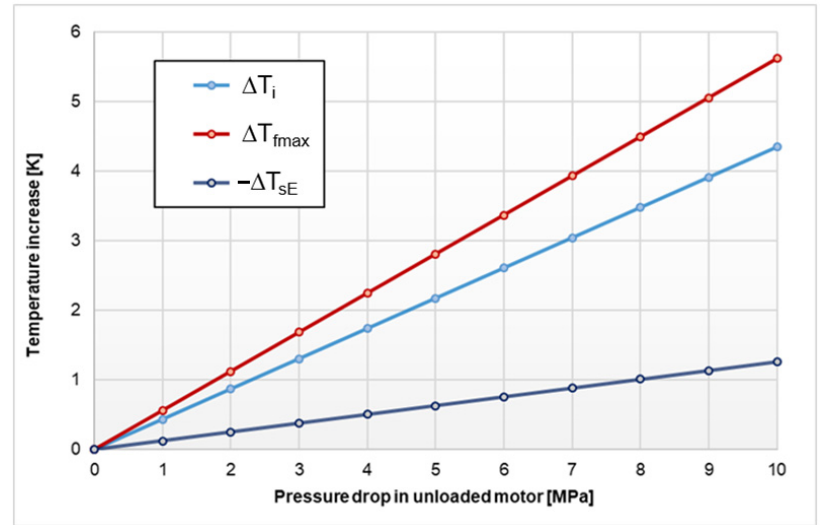
Figure 8. Isenthalpic temperature increase Δ T i and increase in Δ T fmax are proportional to the loss of hydraulic energy in the unloaded motor (throttle valve) depending on the pressure drop for the Hydrol 40 mineral oil at the temperature of 40 °C at the inlet.